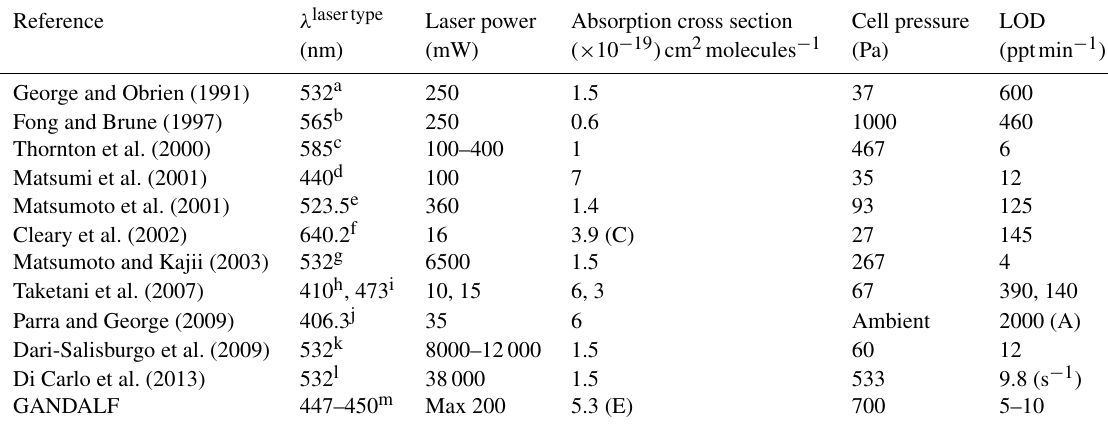
Table 1. Overview of different LIF instruments.